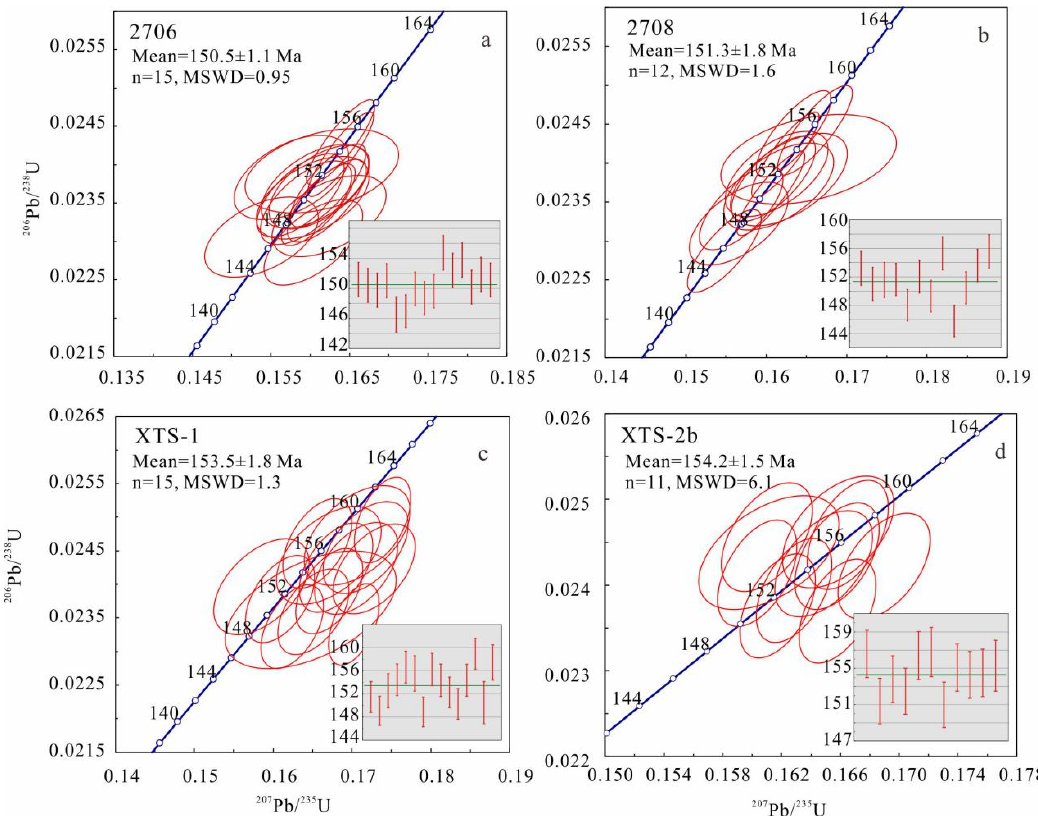
Figure 5. Zircon U-Pb ages of the host granites ( a , b ) and MEs ( c , d ) from the Xitian